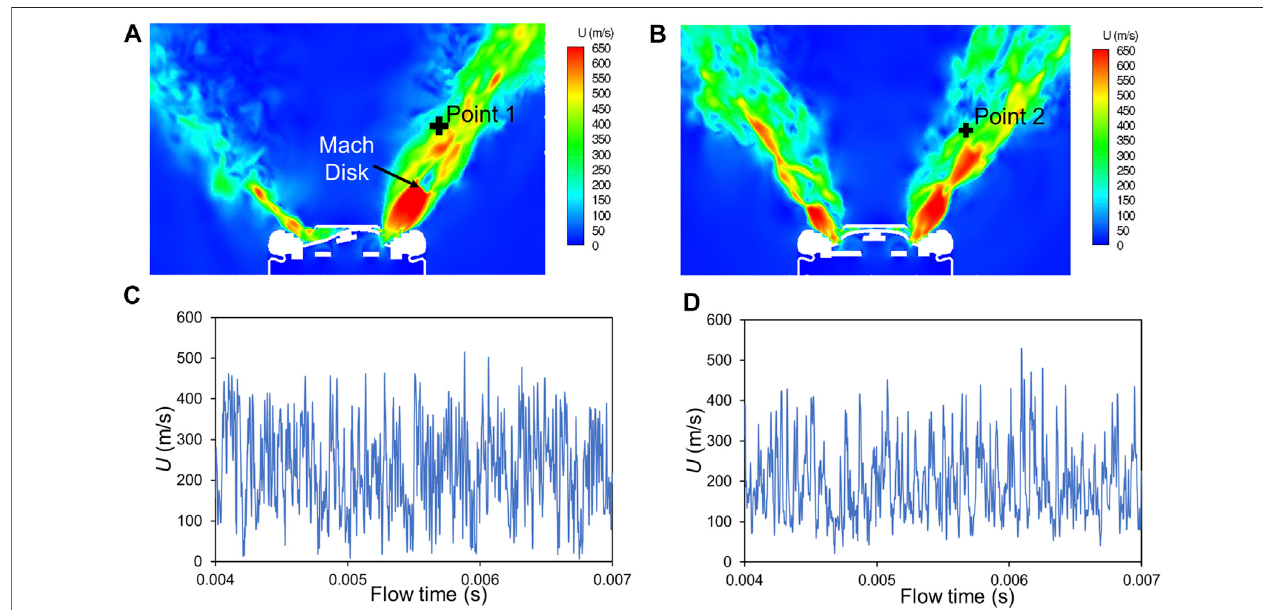
FIGURE 10 | SRS simulated instantaneous velocity magnitude for the LG MJ1 cap at P 1 /P 2 (cid:1) 23.7 in the x-normal (A) and z-normal (B) planes and instantaneous velocity magnitude plotted for 3 ms of fl ow time for point 1 (C) and point 2 (D) .